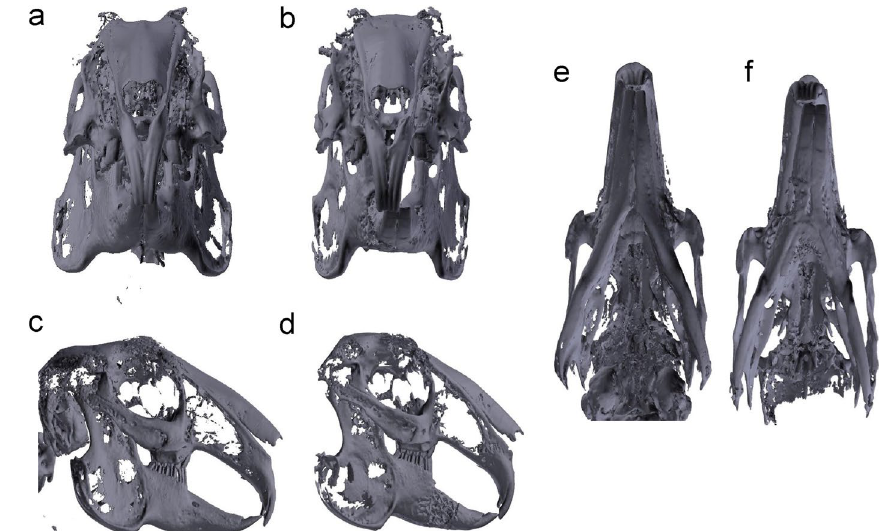
Fig. 3 Three-dimensional (3D) reconstruction image of the mandible obtained pre- and postoperatively. a Frontal view preoperatively; b frontal view postoperatively; c lateral view preoperatively; d lateral view postoperatively; e basal view preoperatively; f basal view